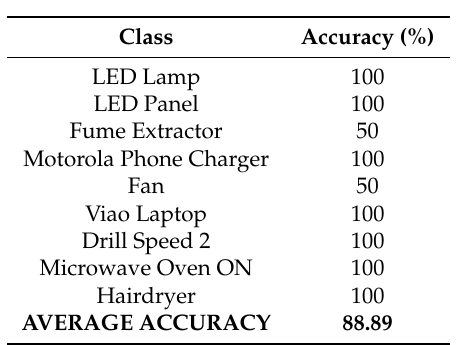
Table 4. Accuracy of CNN testing result using single